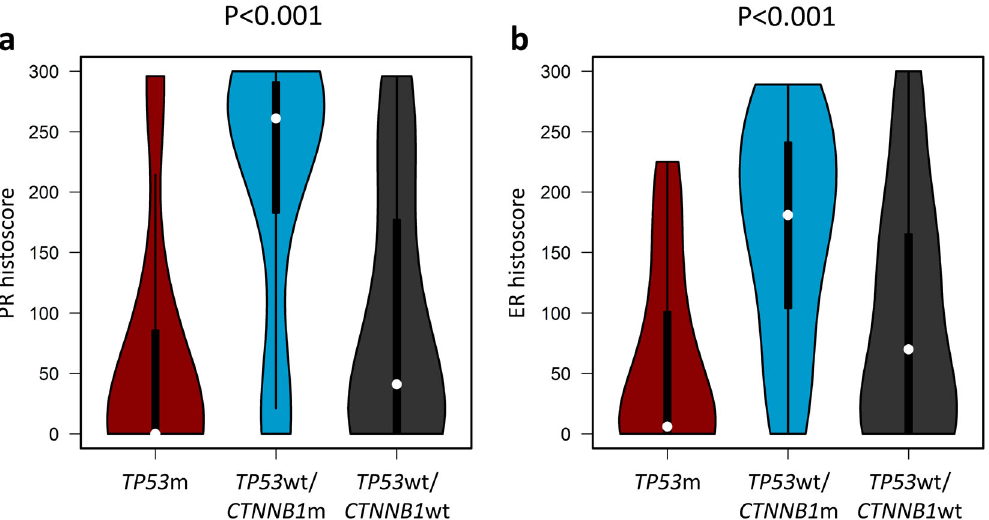
Fig. 4 Hormone receptor expression across genomic subtypes of endometrioid ovarian carcinoma. a Histoscore for progesterone receptor (PR) expression. Labelled P value denotes comparison of TP53 m ( n = 22) and TP53 wt/ CTNNB1 m ( n = 39) cases with a two-sided Mann Whitney- U test; additionally, TP53 m vs TP53 wt/ CTNNB1 wt ( n = 29) P = 0.119 and TP53 wt/ CTNNB1 wt vs TP53 wt/ CTNNB1 m P < 0.001. b Histoscore for oestrogen receptor (ER) expression. Labelled P value denotes comparison of TP53 m and TP53 wt/ CTNNB1 m cases with a two-sided Mann